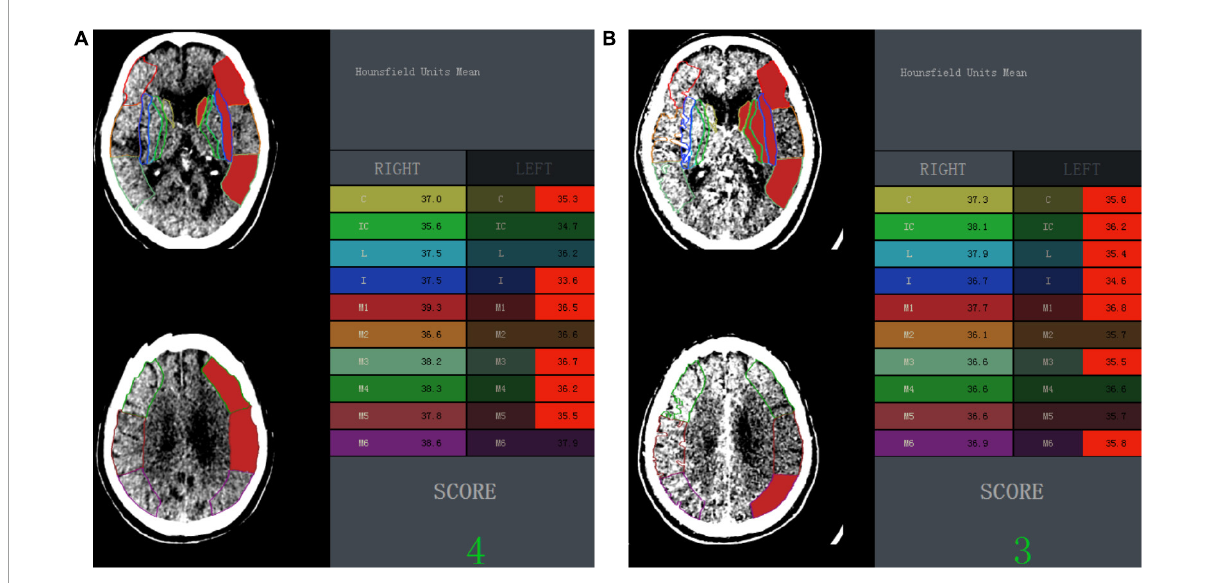
FIGURE2 One example illustrating the automated ASPECTS and wHU-ASPECTS value. (A) In an 84-year-old man with symptomatic onset to CT time within 4.5 h and CTP-based ischemic core of 176.33 ml, the automated ASPECTS on NCCT image was 4 and wHU-ASPECTS on NCCT was –0.859, both indicated a correct classification of the ischemic extent of ischemic core volume ≥ 70 ml according to the maximum Youden index-associated cutoff value. (B) In the same patient, the automated ASPECTS on CTA source image was 3 and wHU-ASPECTS on CTA was –0.746, and both indicated a correct classification of ischemic core size according to the associated cutoff value. ASPECTS indicates Alberta Stroke Program Early CT Score; wHU-ASPECTS, sum of the products of regional relative HU values times corresponding weighting factors.